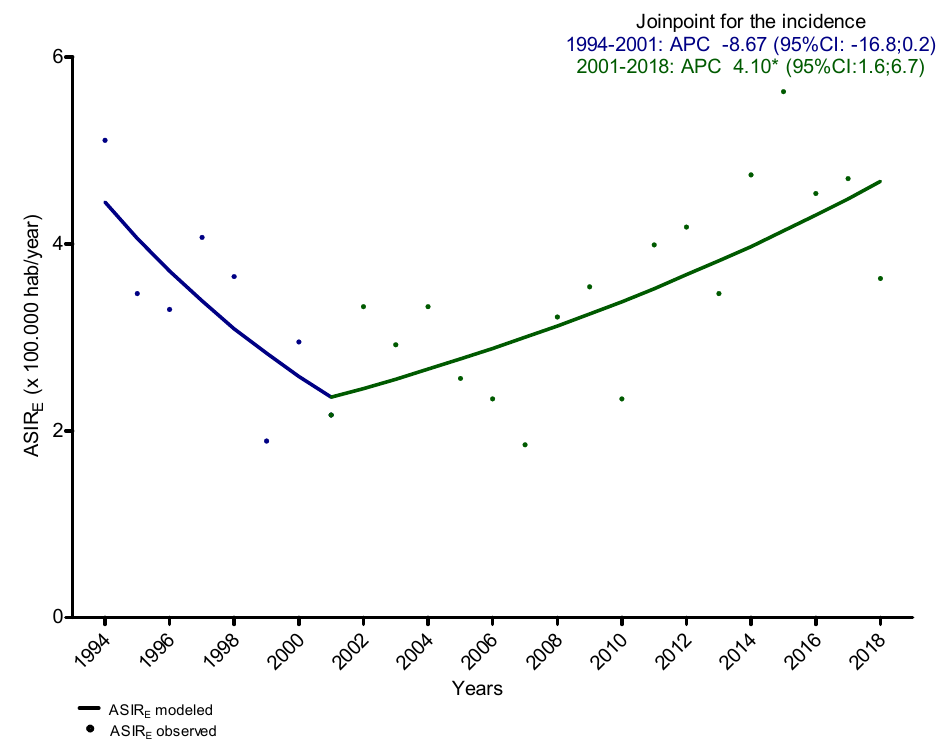
Figure 2. Trends in incidence of overall oropharyngeal cancer, from 1994 to 2018. Joinpoint analysis of age-standardized to the European population incidence rates (ASIR E ) assessing specific turning points. APC: Annual Percentage Change . * statistically significant. Table 2. Cases evaluated or not for p16 expression, according to calendar period .